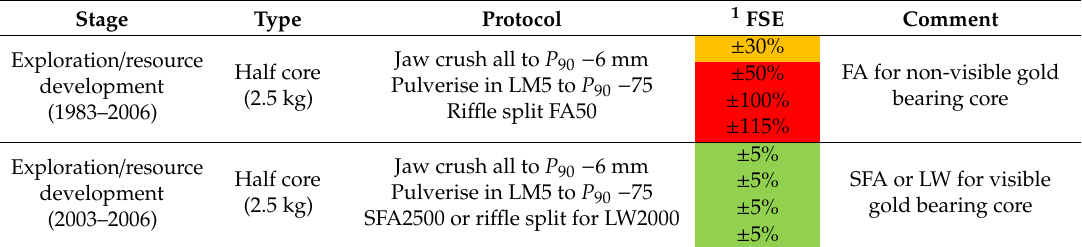
Table 9. FSE for NQ / NQ2 core protocols at the breakeven cut-o ff grade (BCOG) (4 g / t Au) applying the d 95Au scenarios defined in Table 6. Fundamental sampling error (FSE) assumes the presence of coarse gold in the